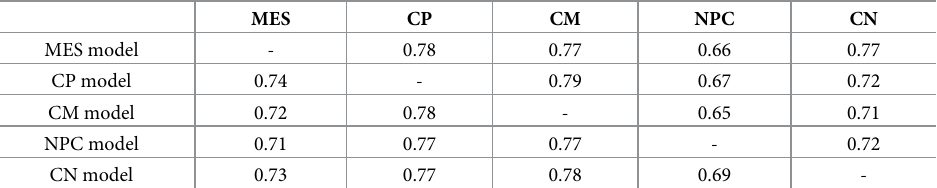
Table 2. Performance of each BP differentiation model at every differentiation time point. MES CP CM NPC CN MES model - 0.78 0.77 0.66 0.77 CP model 0.74 - 0.79 0.67 0.72 CM model 0.72 0.78 - 0.65 0.71 NPC model 0.71 0.77 0.77 - 0.72 CN model 0.73 0.77 0.78 0.69 - For each time point of cardiac (MES/CP/CM) and neural (NPC/CN) BP models (rows), the performance of the BP predictive models is shown for each cell type (columns). The performance values are represented as Pearson’s correlation ( r ) between the measured expression and the predicted one. CM, cardiomyocytes; CN, cortical neurons; CP, cardio precursors; MES, mesoderm; NPC, neural